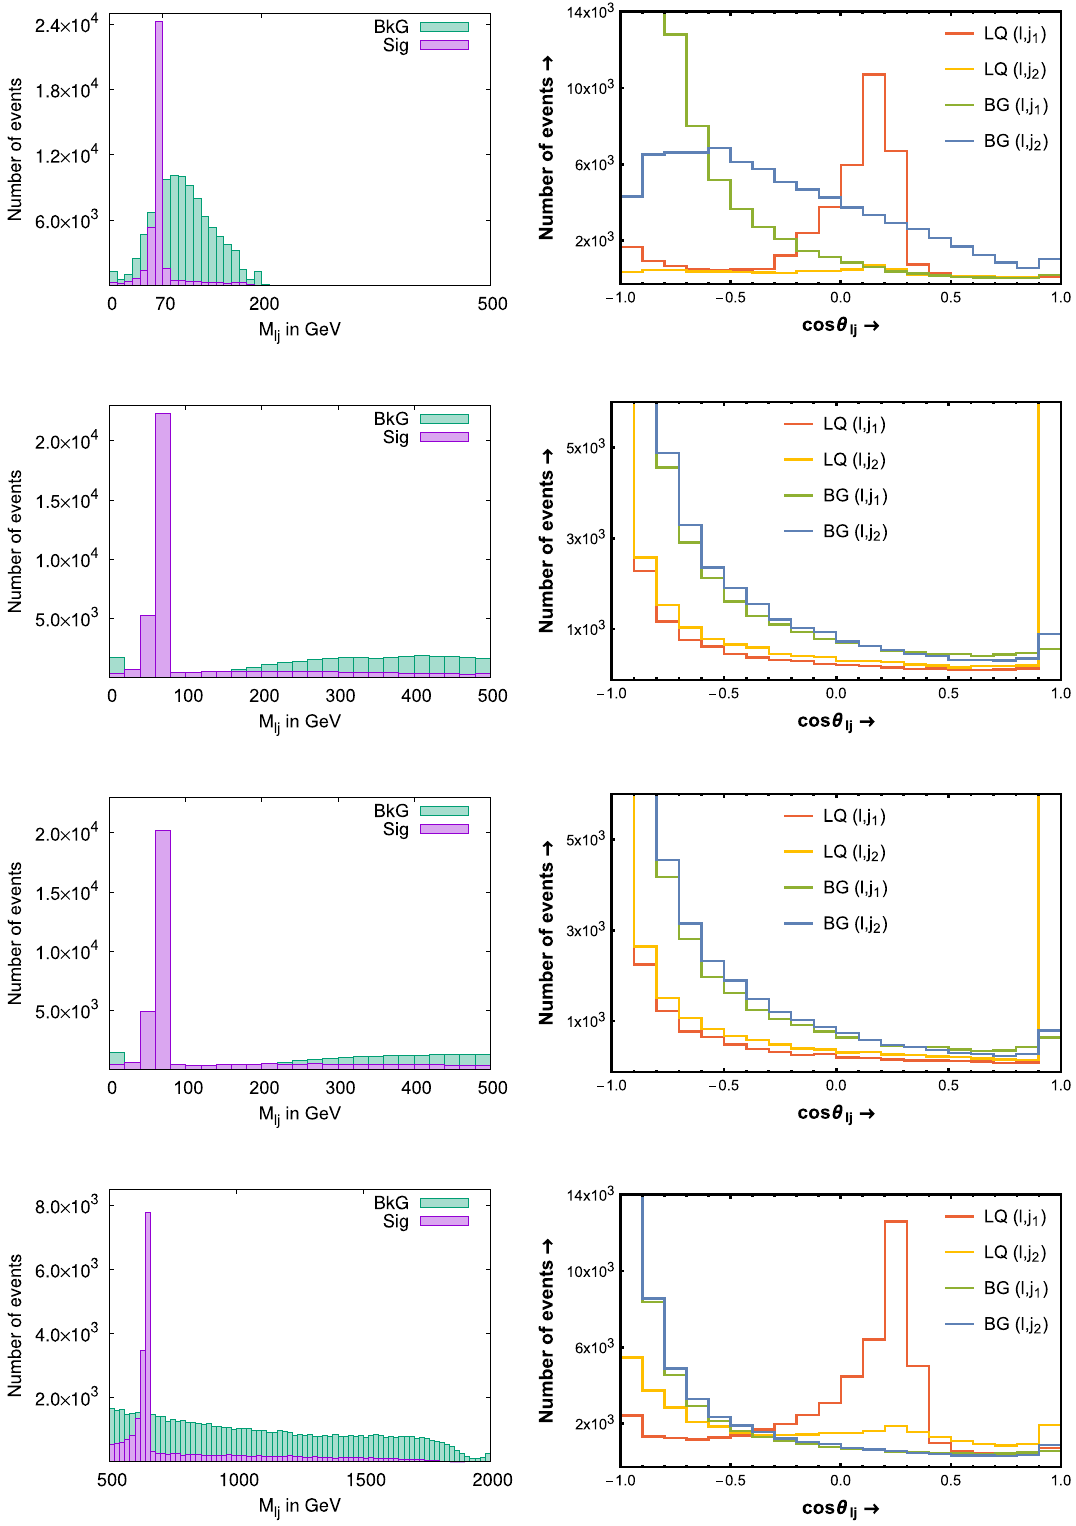
Fig. 5 Signal-background simulation for leptoquark ( S + 1 / 3 ) c for 10 5 numberofevents.TheplotsareorganizedinthesameorderasinTable6. In the left panel, we show the number of events against the invariant mass of the electron–jet pair for both signal (purple) and background (aqua). In the right panel we present the number of events for signal